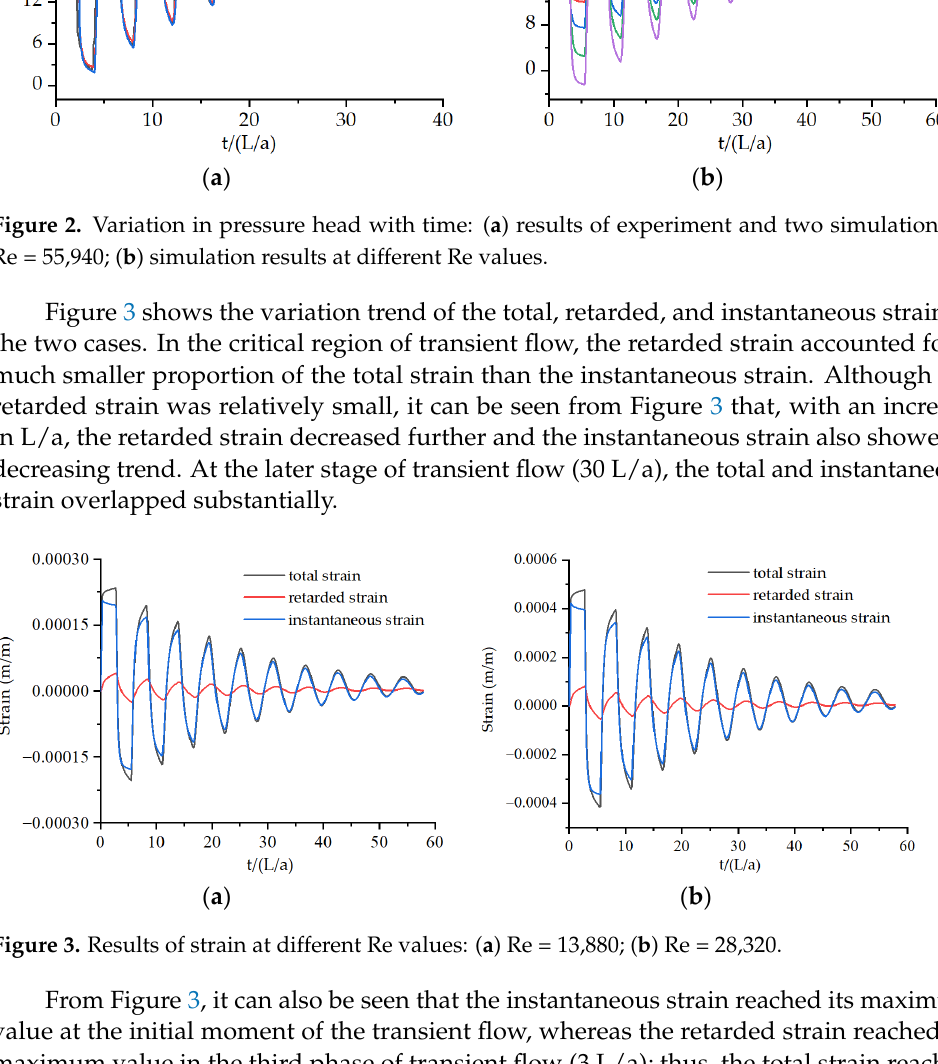
( b ) Figure 4. Variation of ( a ) retarded and ( b ) instantaneous strain at different Re values. Figure 5 illustrates the time difference ( ∆𝑡 ) between the extreme value (peak no.) of retarded strain and instantaneous strain (the time of retarded strain/the time of instanta- neous strain). According to the line graph, the time difference is the biggest at the first few peak numbers of the Re values, whereas it is closer at the end peak number. This means that different Reynolds numbers have greater influence on the first few cycles of strain, that is, viscoelasticity is obvious in the early phase of transient flow. During the whole period of transient flow, the time difference between retarded strain and instantaneous strain not only shows an upward trend with the peak number monotonic increasing but increases as Re values increase. It would be expected that the retarded strain effect would become smaller with time because the velocity decreases with time; and the difference of Re values also affects viscoelasticity during the transient flow, though not greatly.